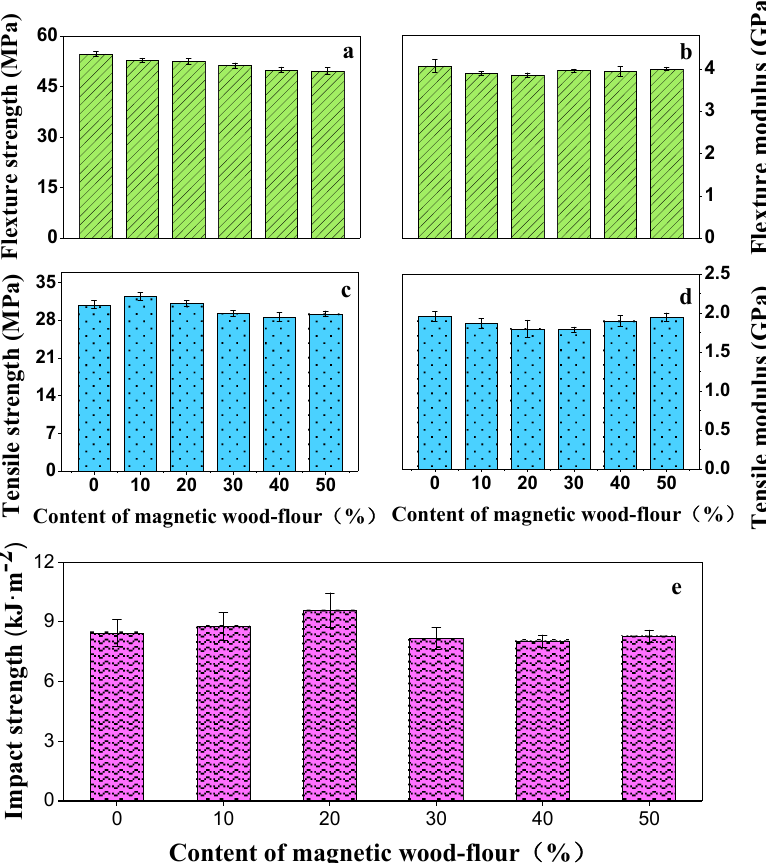
Figure 10. Mechanical properties of the magnetic biocomposites. ( a ) flexural strength; ( b ) flexural modulus; ( c ) tensile strength; ( d ) tensile modulus; ( e ) impact strength.